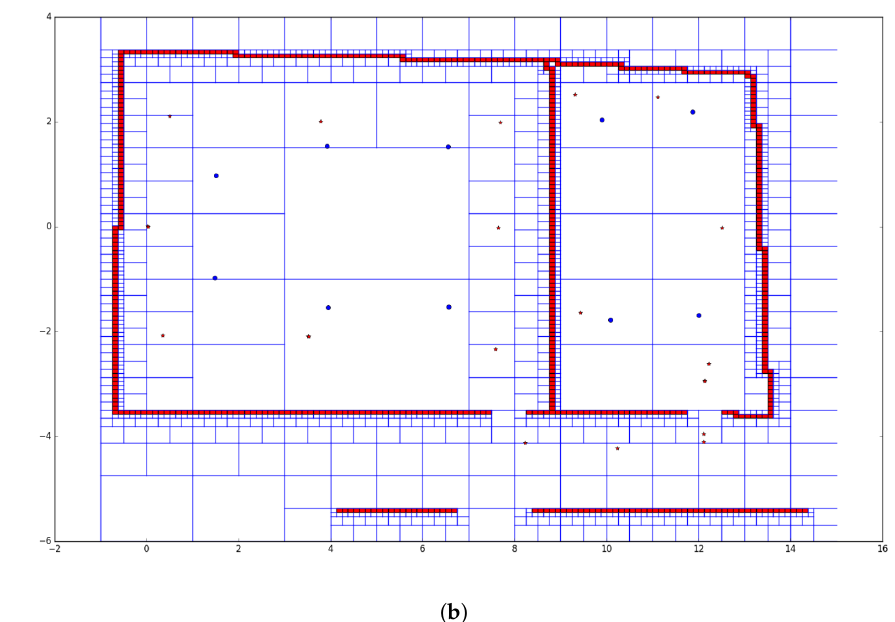
Figure 25. Difference between a real environment model after SLAM and a environment based on the outer boundaries of the real environment. ( a ) environment model after SLAM; ( b ) environment model of the outer boundaries.